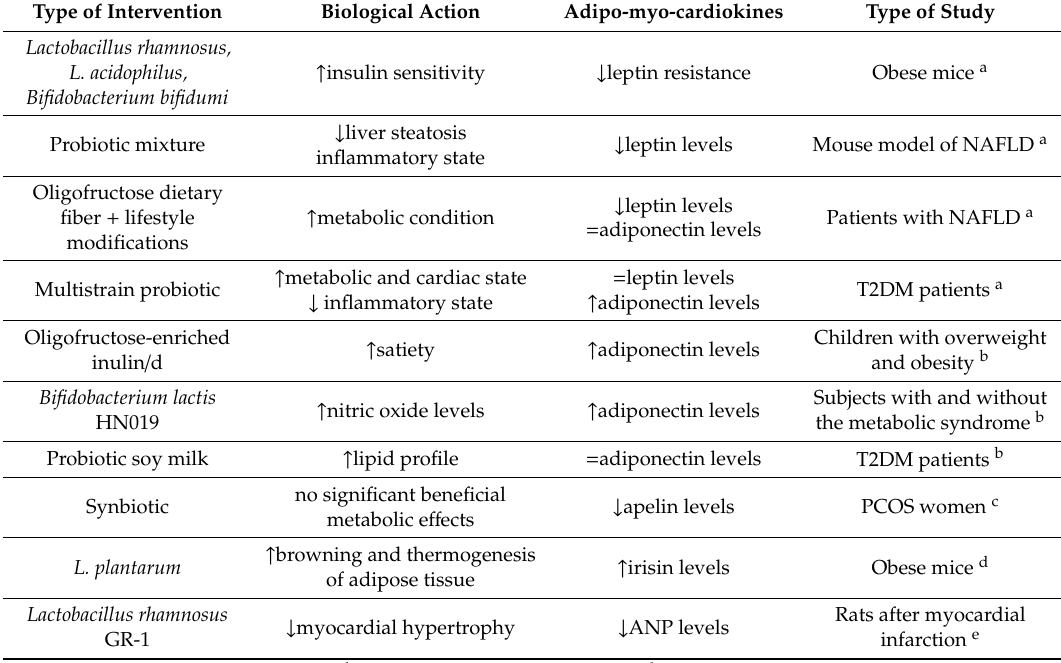
Table 2. E ff ects of prebiotic and probiotic supplementation on adipokines, myokines, and